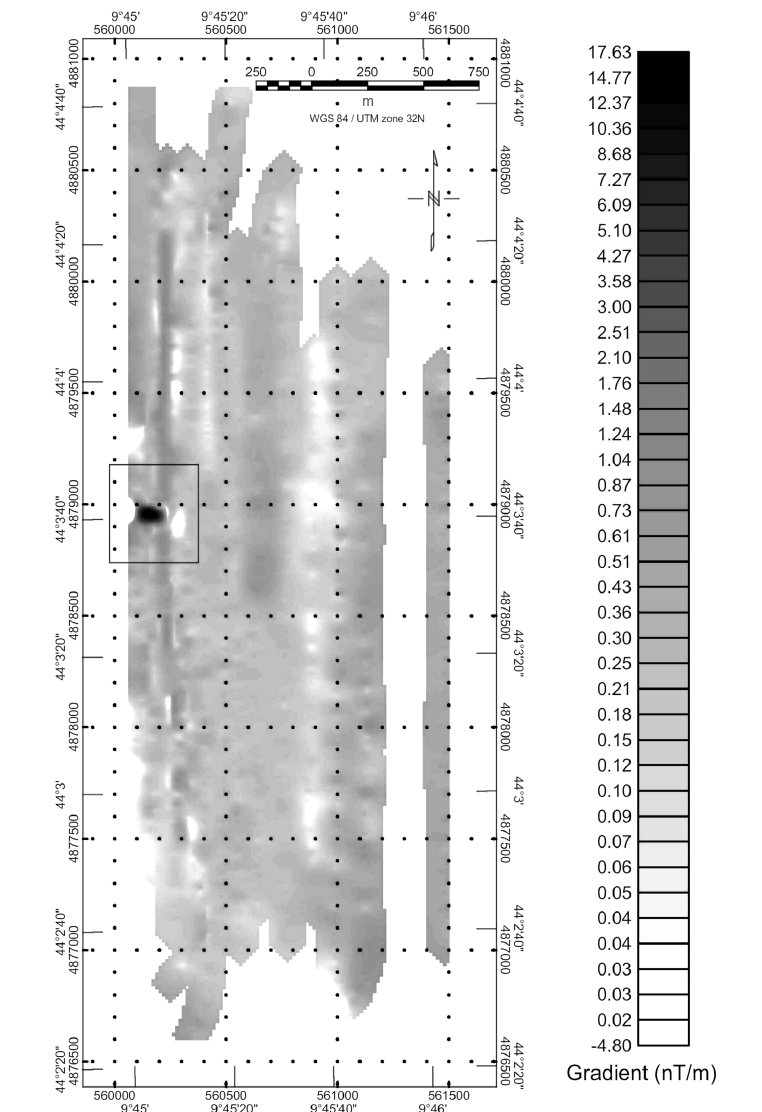
Fig. 6. Transverse horizontal gradiometric map of the offshore site of Scoglio Ferale (black dot on the map) underlying the ship line-paths; values and colour range [ − 1.8 white, + 12.7 black]